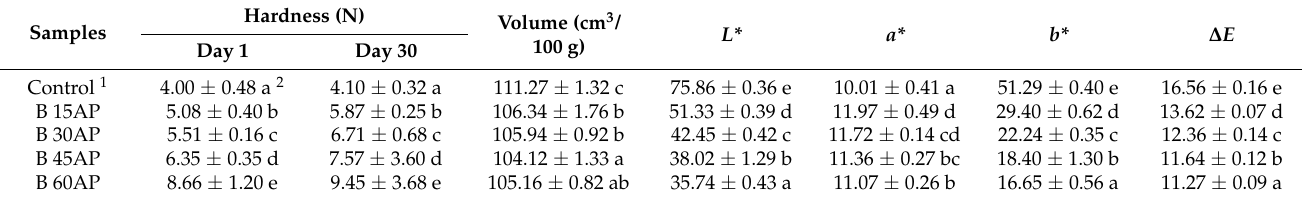
1 Sample coding: see Table 1; 2 different letters in the column denote statistically different average values ( α = 0.05, for hardness n = 7, for volume n = 2, for color parameters n =